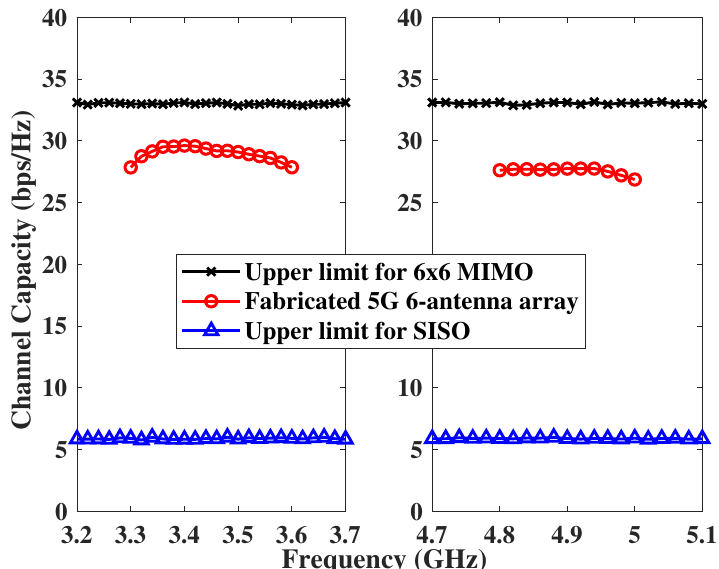
Figure 10. Calculated ergodic channel capacities of 5G antenna array prototype in 6 × 6 MIMO system.